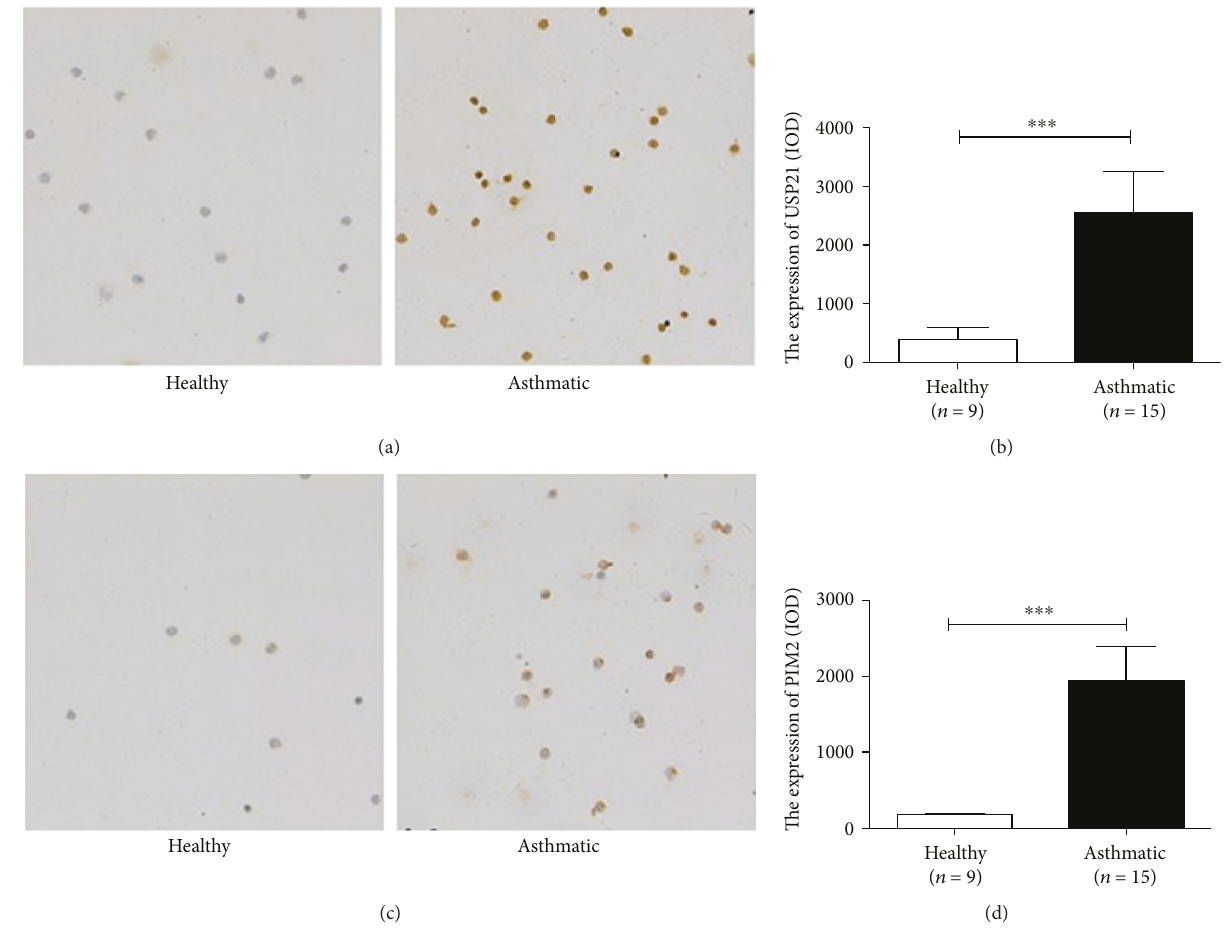
Figure 6: Increasing expression of USP21 and PIM2 in Treg cells from asthmatic patients. (a, c) USP21 and PIM2 staining in CD4 + CD25 + Treg cells (revealed in brown, 200x). (b, d) The expression level of USP21 and PIM2 in CD4 + CD25 + Treg cells from healthy ( n = 9 ) and asthmatic ( n = 15 ) subjects. The graph shows means ± sem . ∗∗∗ p < 0 001 . NS: no signi fi